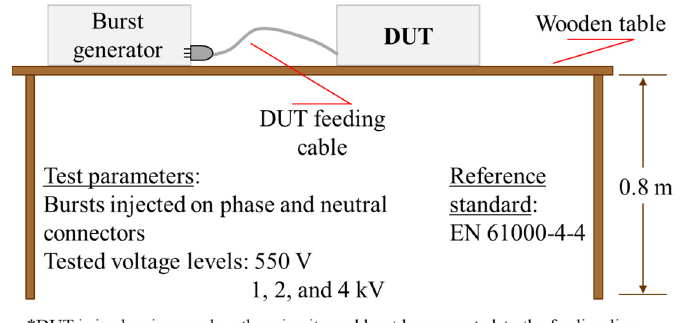
Figure 4. Fast transient burst test.